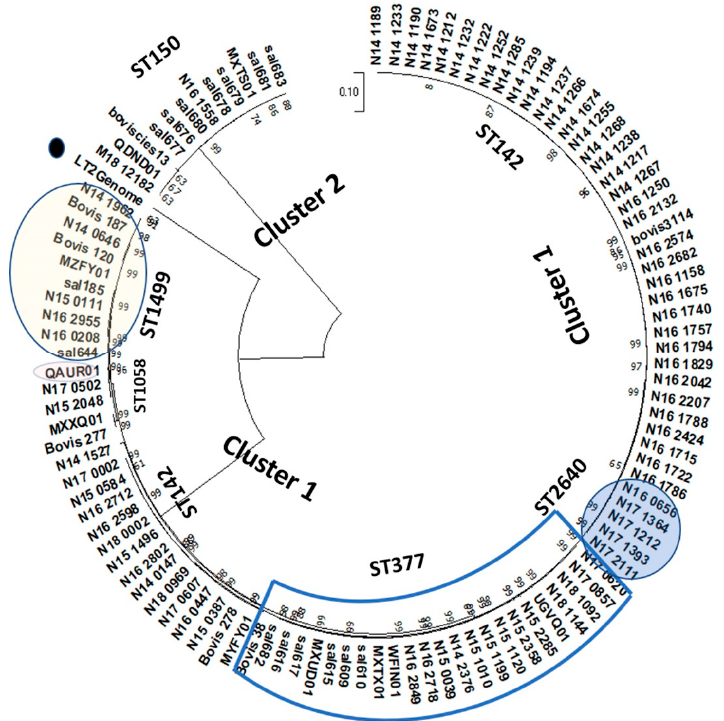
Figure 1. Wg ‐ core gene analysis of 95 S. Bovismorbificans identifies two distinct clusters having different genomic backbones. S. Bovismorbificans strains were obtained from clinical, animal, feed or food and water or unknown sources isolated during 1984–1989 and 2011–2018 (from this study) and representative strains from NCBI. Cluster analysis was carried out using single nucleotide polymorphisms in 2690 core genes representing conserved backbone, and the phylogenetic tree was developed using the Maximum ‐ Likelihood method [30] available on MEGAX’s phylogenetic suite [32]. S . Typhimurium (LT2. single dot) was used as an outlier. Alleles in 48,344 positions were considered across 110 genomes spanning 2650+ out of 2690 core genes, which were considered tested over 500 bootstrapping iterations. The resulting circular tree is shown here. A browsable vertical layout of the tree is available in Supplemental Figure S1. Refer to Supplemental File S2 on the page for the comprehensive allelic data matrix from this analysis.